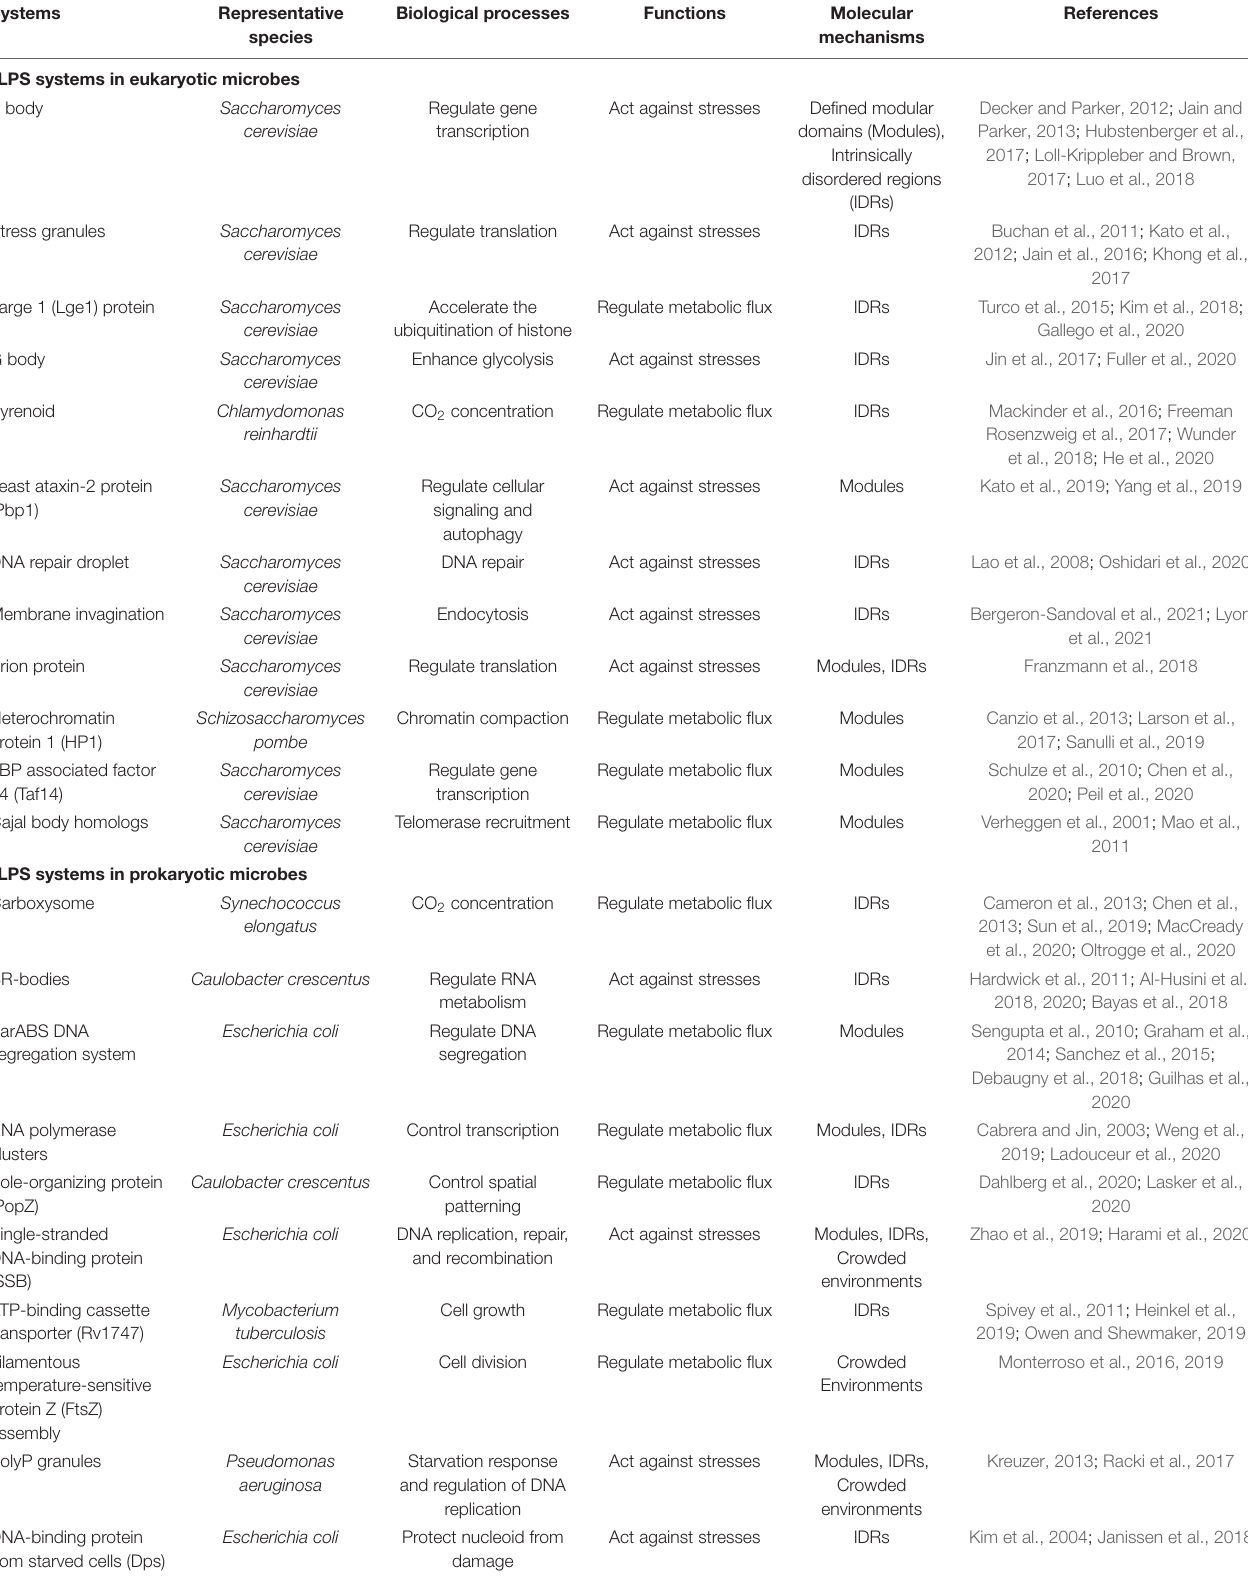
TABLE 1 | Proposed phase-separated biomolecular condensates in microbial